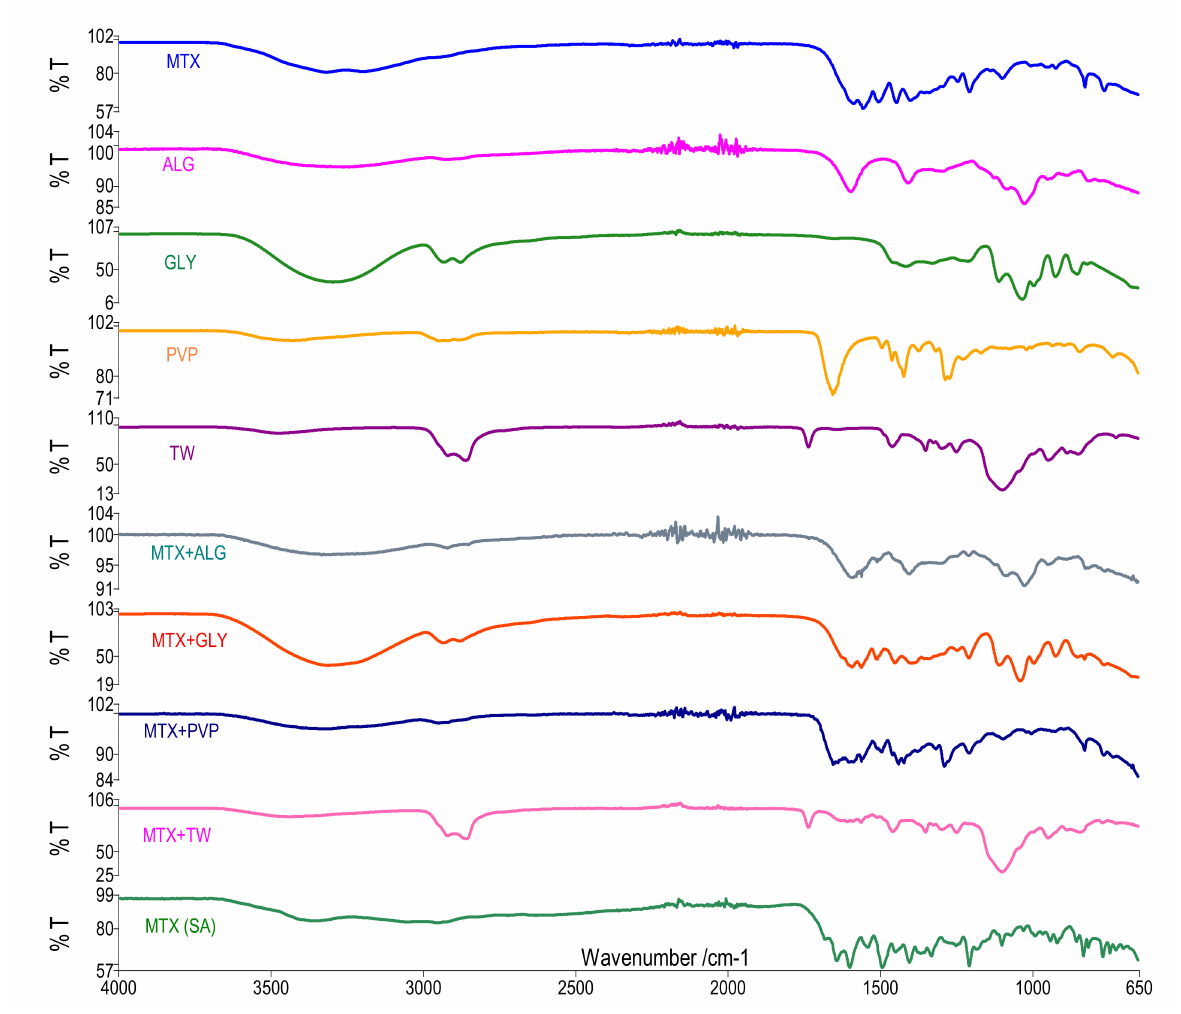
Figure 10. FT-IR